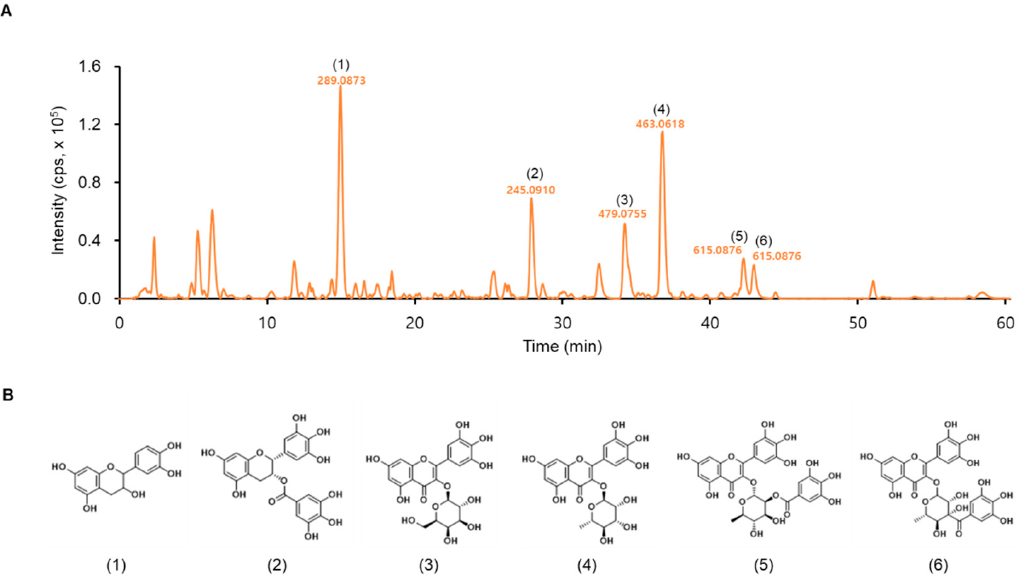
Figure 1. Analysis of Limonium tetragonum water extract (LTE). ( A ) LC/Q-TOF MS chromatogram (intensity measured in counts per second, cps) of LTE using negative ion mode. ( B ) Structures of the predominant substances in LTE. ( 1 ): epicatechin ( 2 ): ( − )-epigallocatechin-3-gallate, ( 3 ): myricetin-3-O- β -D-galactopyranoside, ( 4 ): myricetin-3-O- α -L-rhamnopyranoside, ( 5 ): myricetin-3-O-(2 ″ -O-galloyl)- α -L-rhamnopyranoside, and ( 6 ): myricetin-3-O-(3 ″ -O-galloyl)- α -L-rhamnopyranoside.